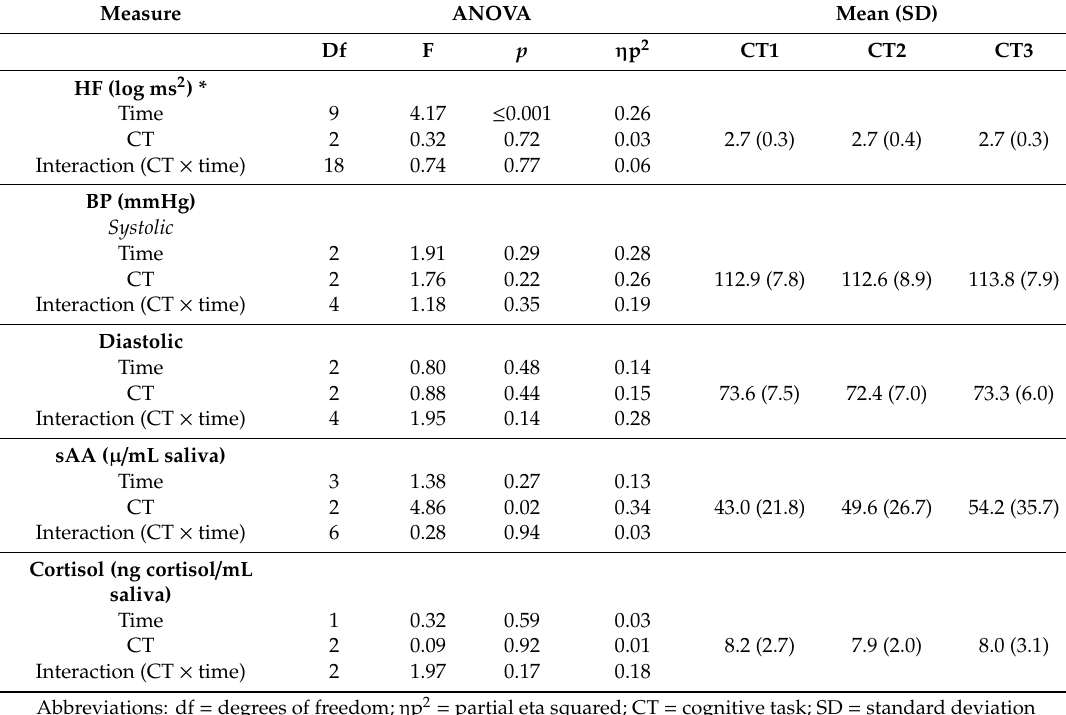
Figure 5. Development of root mean square of the successive differences between R–R intervals (RMSSD) across consecutive pipetting work-bouts (WB). At ach time point on the x-axis, corresponding to the pipetting work bouts, a mean value for RMSSD across participants is presented. Separate lines illustrate cognitive task (CT) difficulties. Standard deviations for means across all participants and all time points.